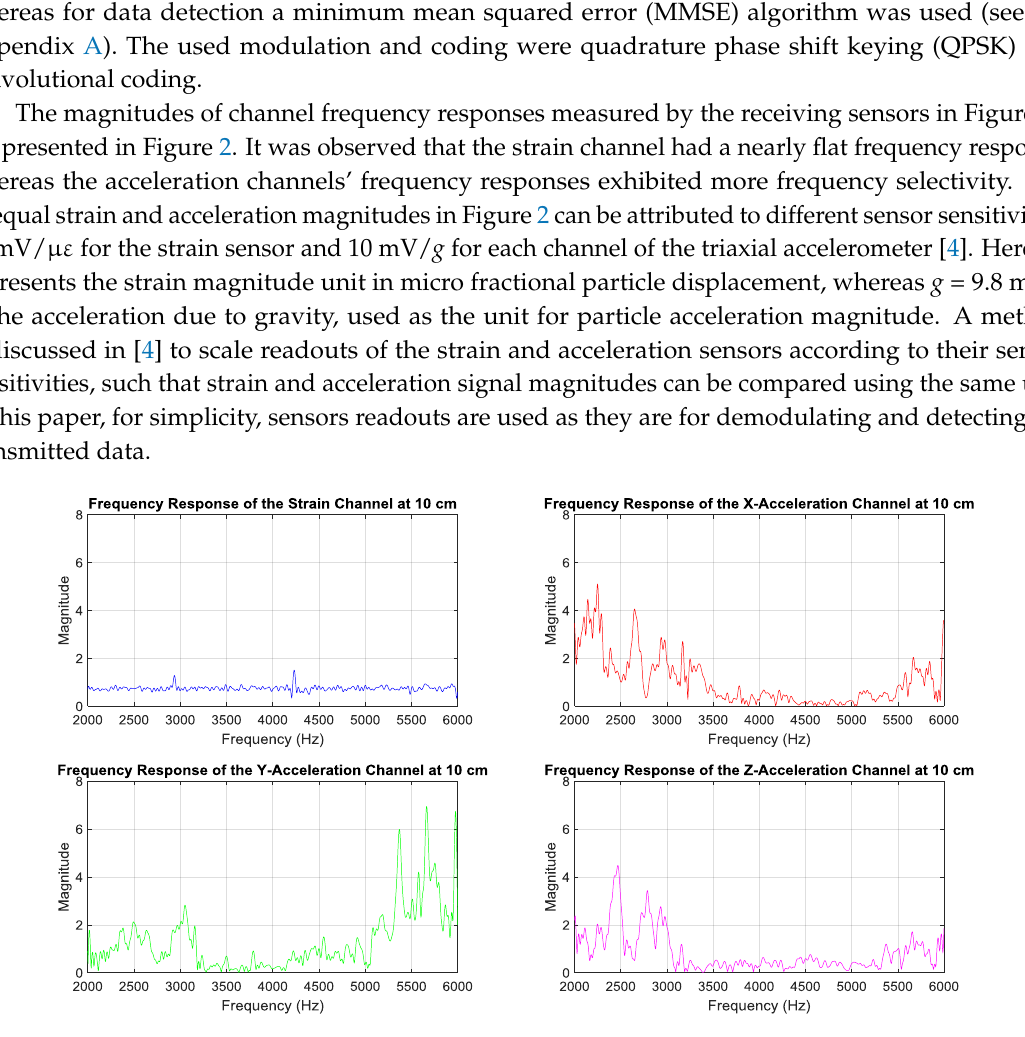
Figure 2. Magnitudes of frequency responses of channels measured by the receiving sensors in Figure 1b.